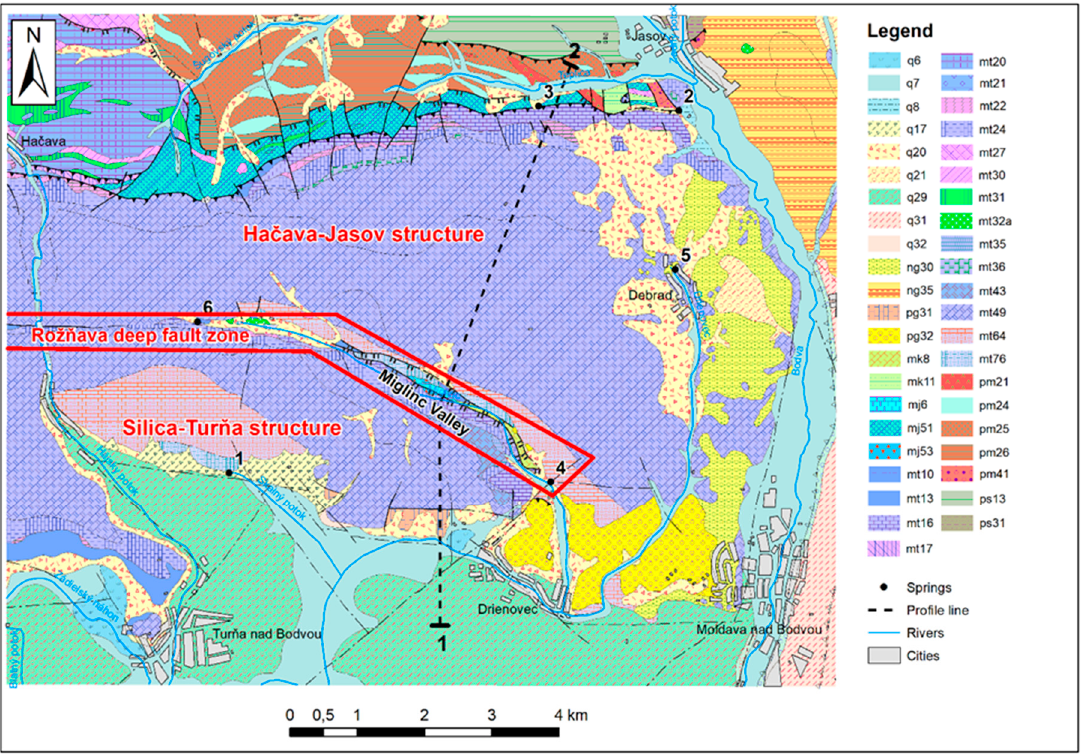
Figure 3. Geological map of the Jasov Plateau Reprinted with permission from ref. [48]. Copyright 2013, State Geological Institute of D. Št ú r. Explanation: Quaternary: Holocene: q6—organic sediments: moors and flood plain peats, q7—fluvial sediments: alluvial loams, q8—proluvial sediments: loams and sandy loams, Pleistocene/Holocene: q17—deluvial– proluvial sediments: loamy and loamy-stony alluvial fans, q20—deluvial sediments: loamy-stony debris,